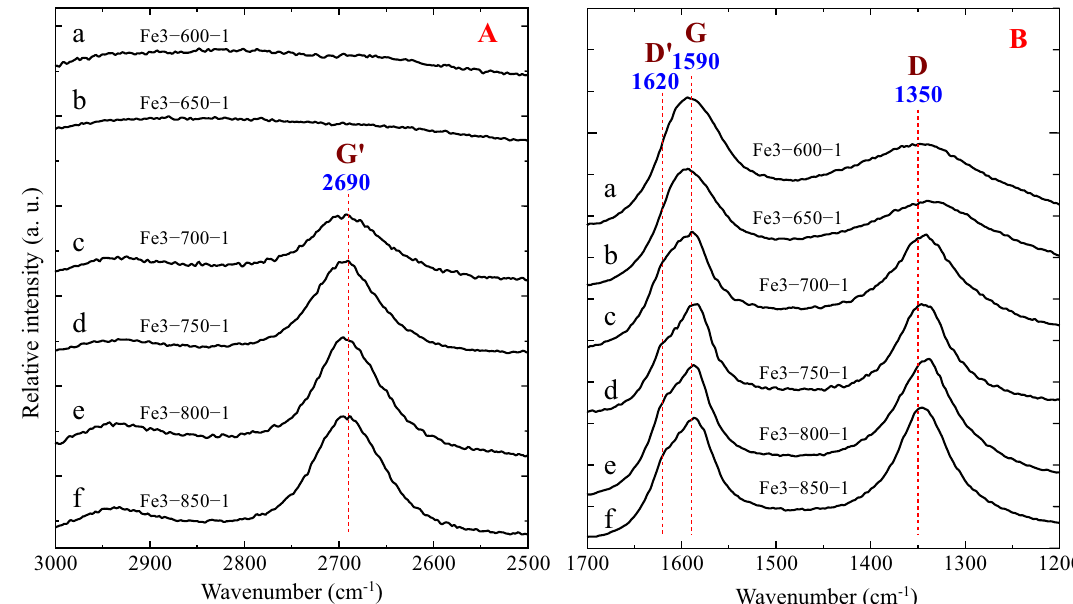
Fig. 2 Raman spectra in two regions, A (3000–2500 cm − 1 ) and B (1700–1200 cm. − 1 ), of Fe3- Y -1: a , Fe3-600-1; b , Fe3-650-1; c , Fe3-700-1; d , Fe3-750-1; e , Fe3-800-1; f , Fe3-850-1